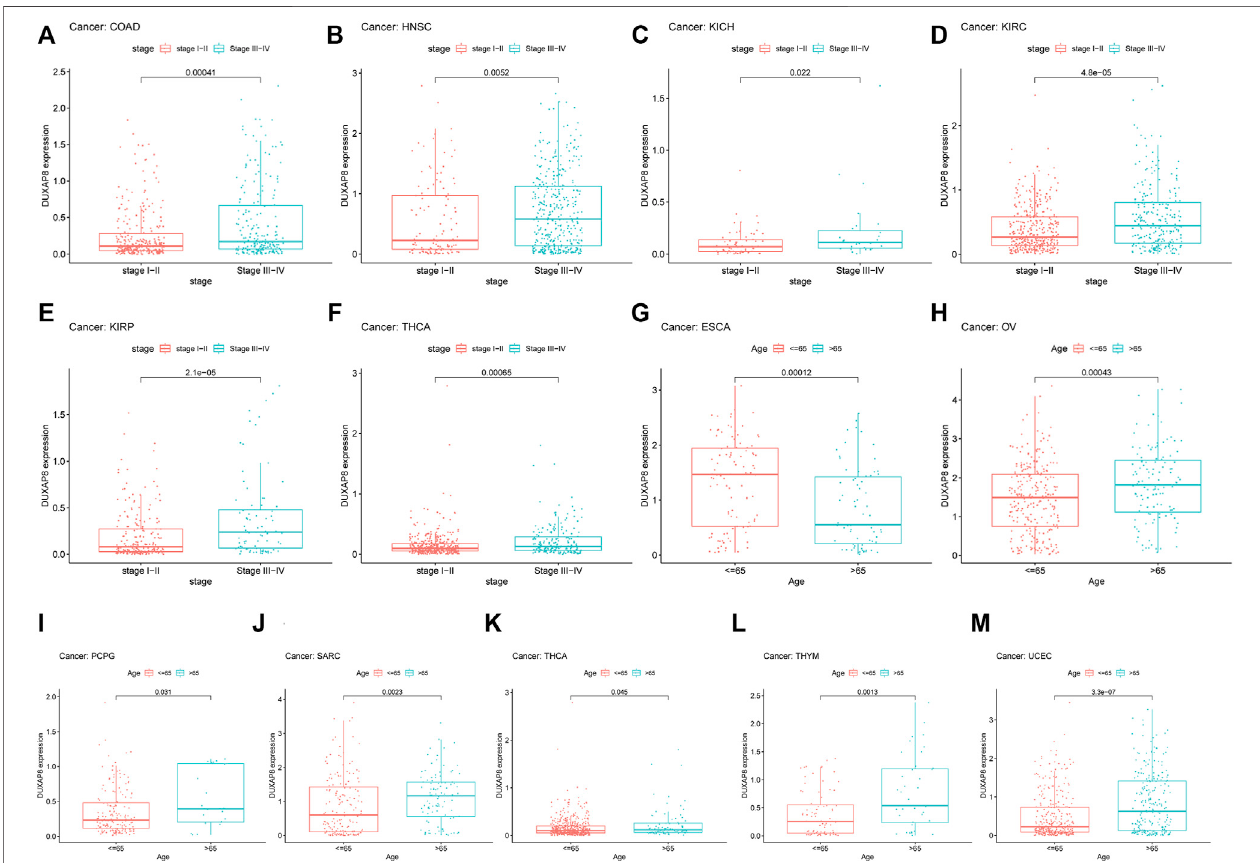
FIGURE5| Relationshipbetweenthe DUXAP8 geneexpressionandclinicopathologicalfeaturesofPan-cancer. DUXAP8 geneexpressionisrelatedtothestagein COAD (A) , HNSC (B) , KICH (C) , KIRC (D) , KIRP (E) , and YHCA (F) . DUXAP8 gene expression is associated with age in ESCA (G) , OV (H) , PCPG (I) , SARC (J) , THCA (K) , THYM (L) , and UCEC (M)